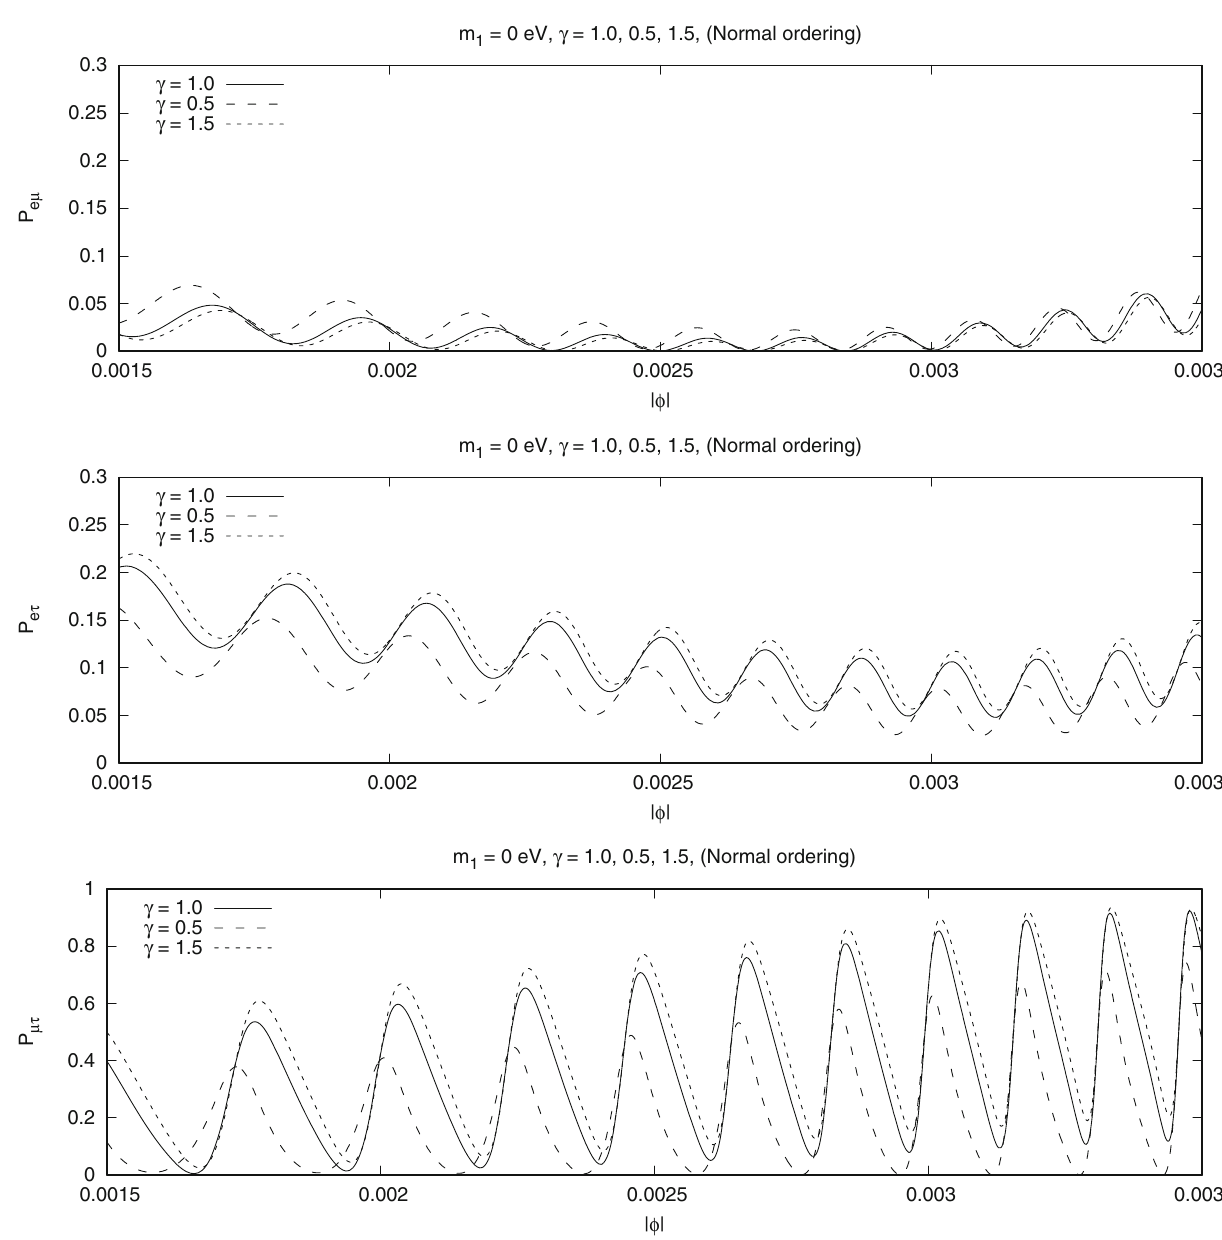
Fig. 7 Oscillation probability for the three flavor case in normal hier- archy with m 1 = 0. Top panel: probability of ν e → ν μ conversion for γ = 1 . 0 (solid line), γ = 0 . 5 (dashed line), γ = 1 . 5 (dotted line). Mid panel: probability of ν e → ν τ conversion for γ = 1 . 0 (solid line), γ = 0 . 5 (dashed line), γ = 1 . 5 (dotted line). Bottom panel: probability